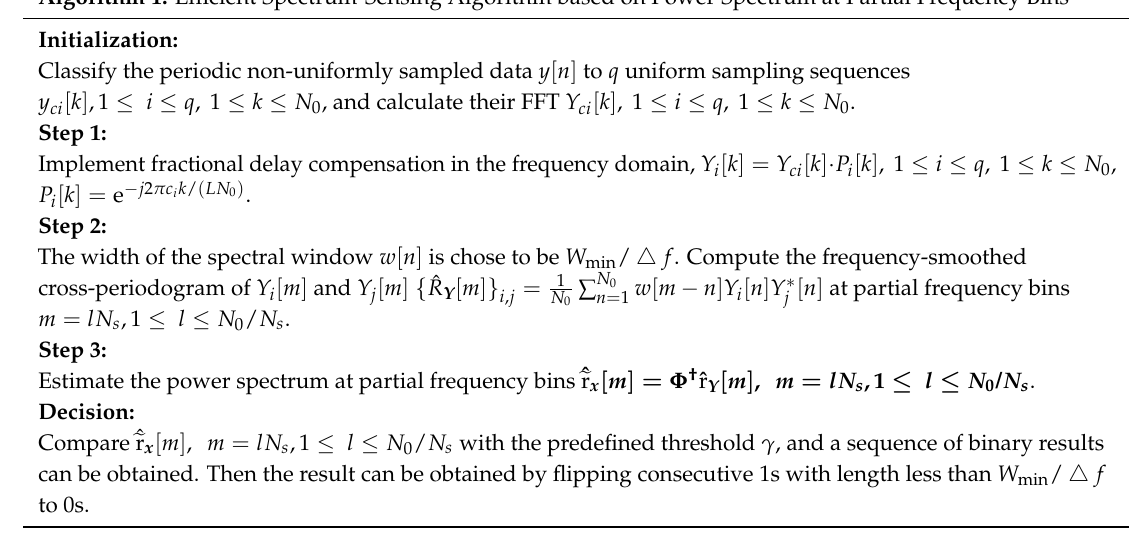
Algorithm 1. Efficient Spectrum-Sensing Algorithm based on Power Spectrum at Partial Frequency